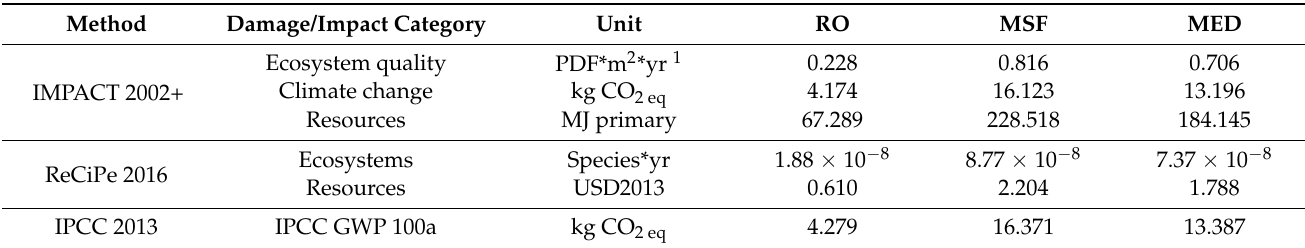
Table 10. Summary of impact assessment results for the three technologies based on the IMPACT 2002+, ReCiPe 2016, and IPCC 2013 methods.